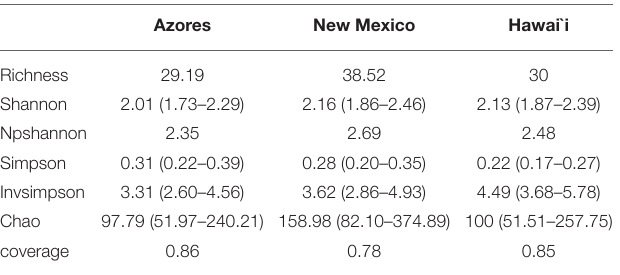
three locations under study.